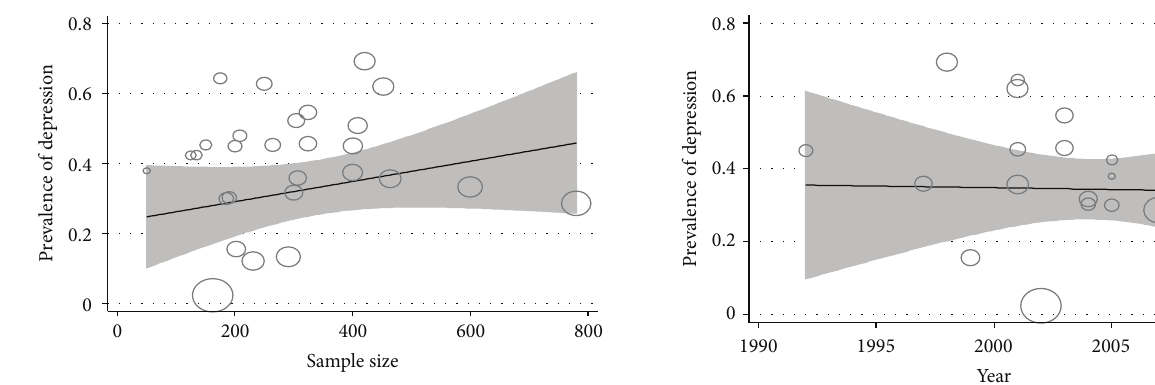
Figure 4: Meta-regression plots of change in depression according to changes in continuous study moderator’s sample size.